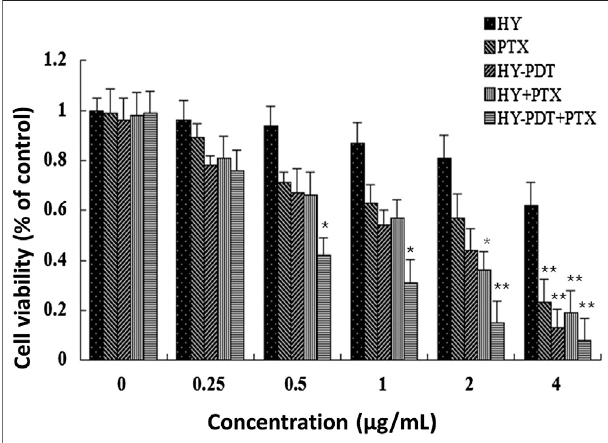
FIGURE 1 | Cytotoxicity of different doses of paclitaxel and HY-PDT on B16-F10 cells. The proliferation rate was assayed by the MTT method. The cellsweretreatedwithdifferentconcentrations(0,0.25,0.5,1,2,and4 μ g/ml) of paclitaxel or (0, 0.25, 0.5, 1, 2, and 4 µg/ml) HY or their combination, HY-PDT treatment. All data are expressed as mean ± SEM from three independent experiments. For the HY-PDT treatment, cells were irradiated vertically for 1 h under a 20 W/30 quartz – halogen lamp (Osram, Berlin, Germany) after hypericin was added, the irradiator fl uence rate was adjusted to 3.15 J/cm 2 , and the cells were then transferred back into normal culture conditionsandcombinedwiththecorrespondingconcentrationsofpaclitaxel. * p < 0.05, ** p < 0.01, compared to the